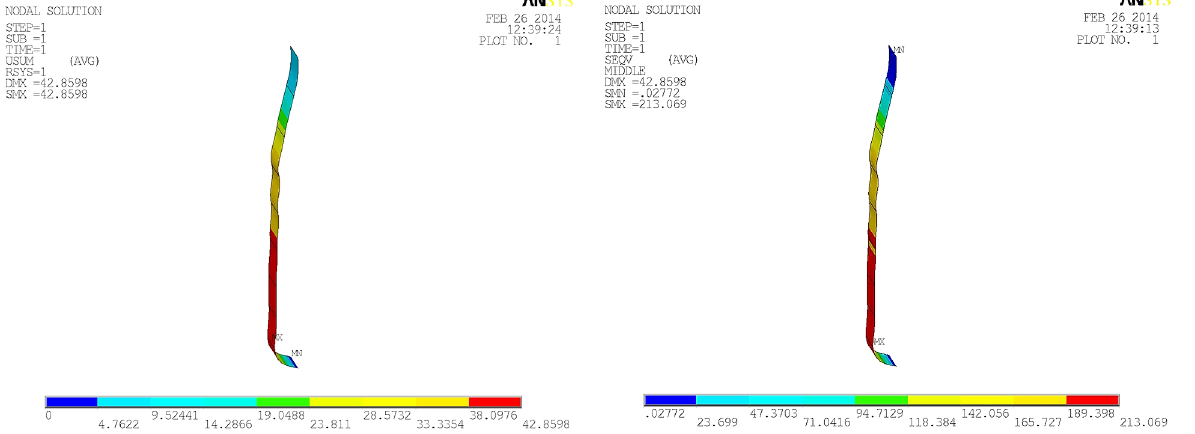
Fig. 8. Total deformation of model D [mm] Fig. 9. Membrane reduced stress acc. to von Mises